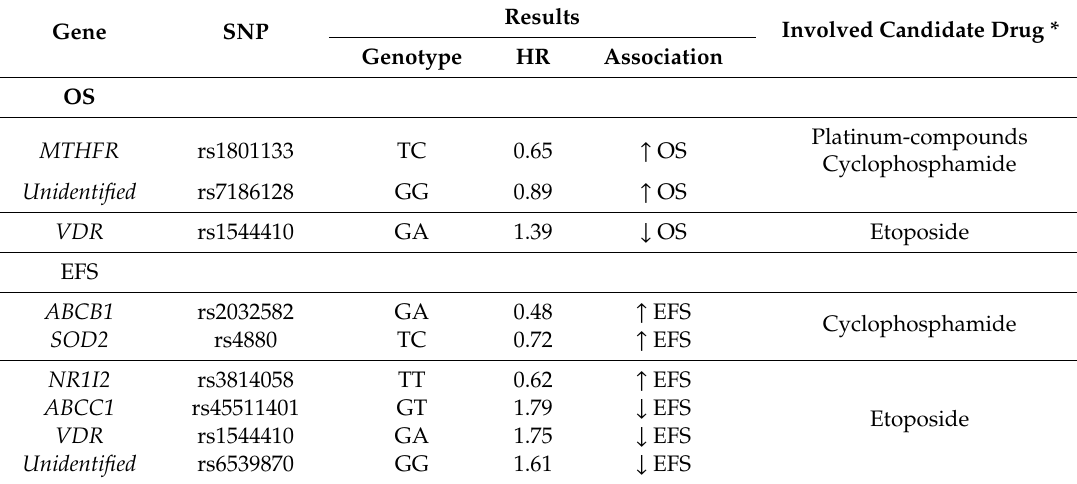
Table 3. SNPs related to E ffi cacy in terms of